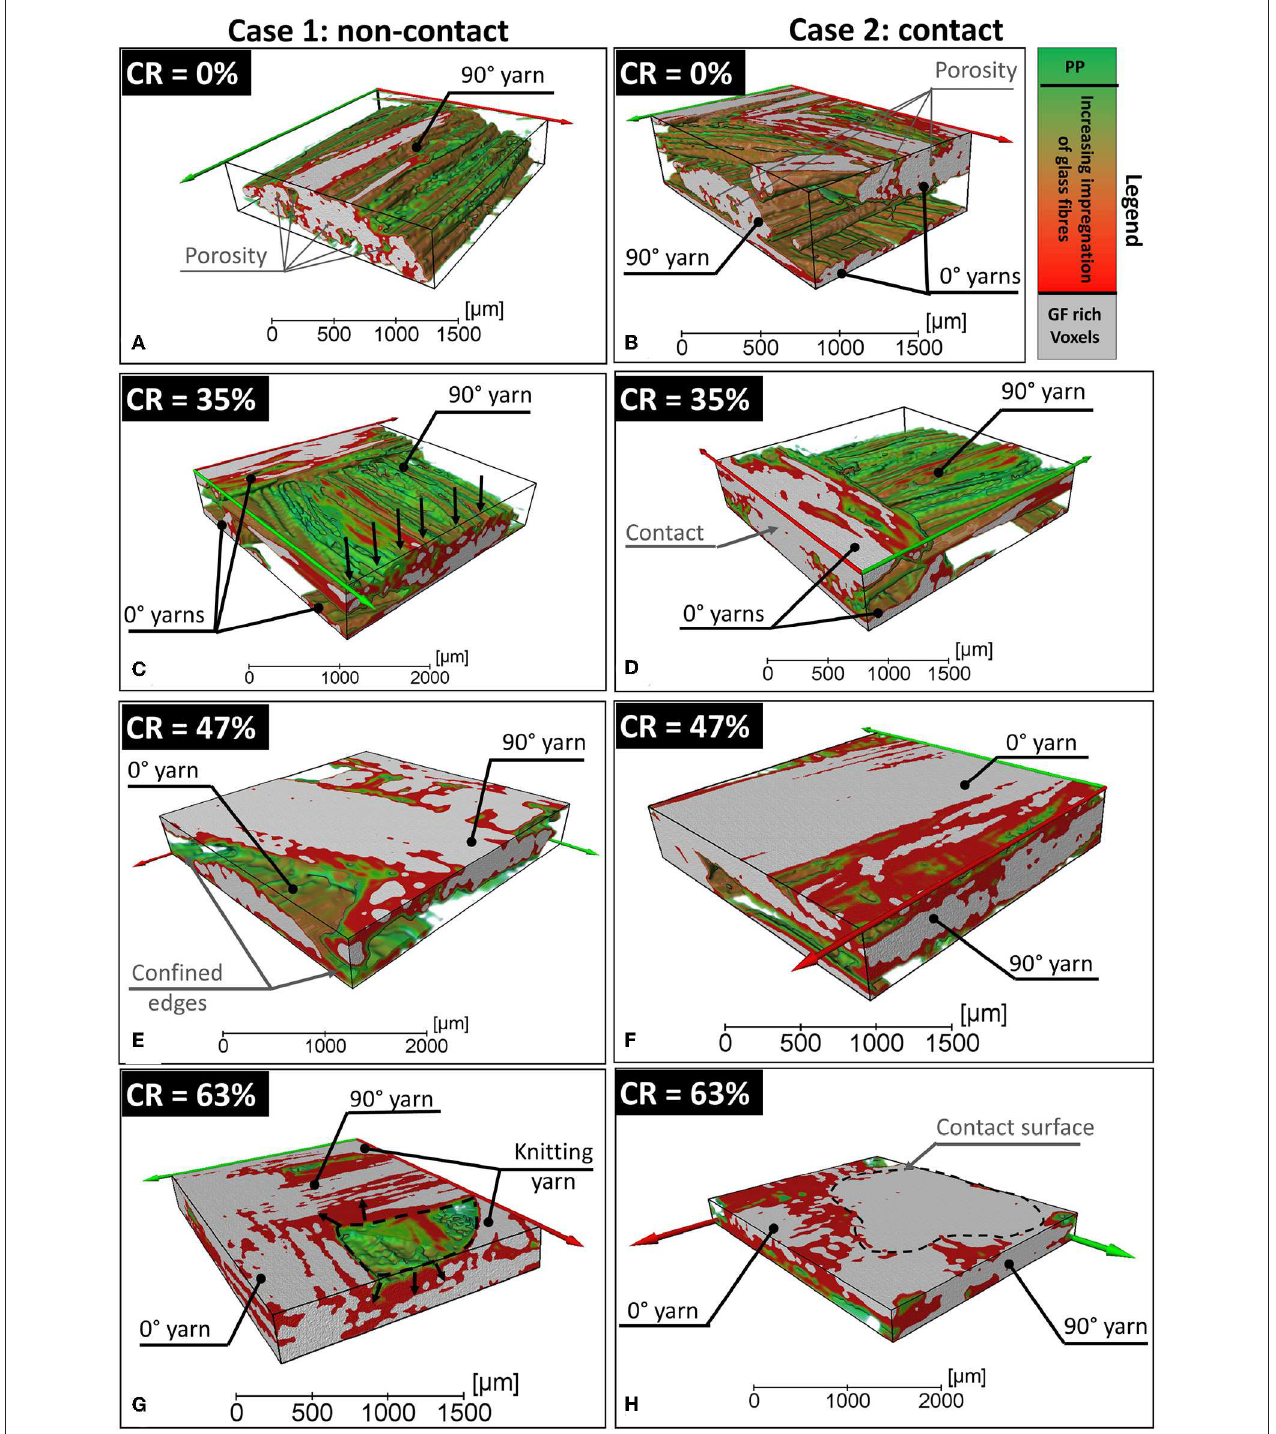
FIGURE 11 | Impregnation degree of reinforcement yarns in the case of non-contact (A,C,E,G) and contact (B,D,F,H) .